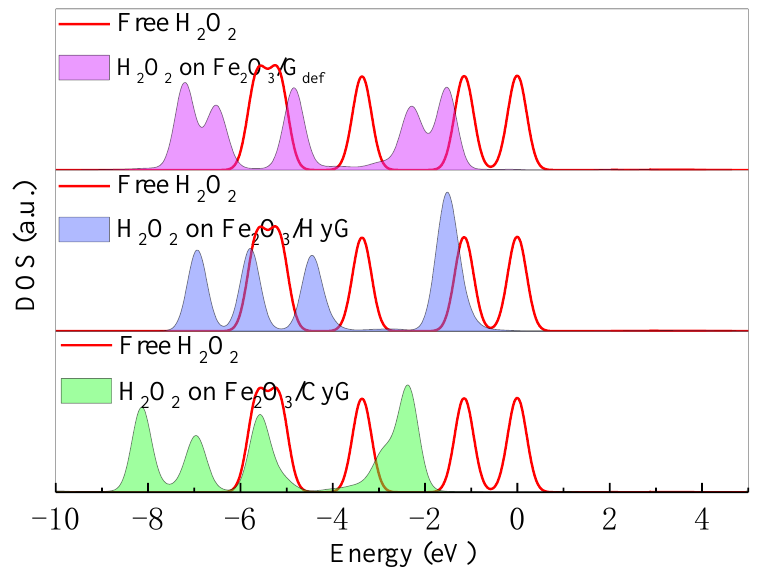
Figure 6. DOS for the free H 2 O 2 , the H 2 O 2 on Fe 2 O 3 /G def , the H 2 O 2 on Fe 2 O 3 /HyG, and the H 2 O 2 on Fe 2 O 3 /CyG.